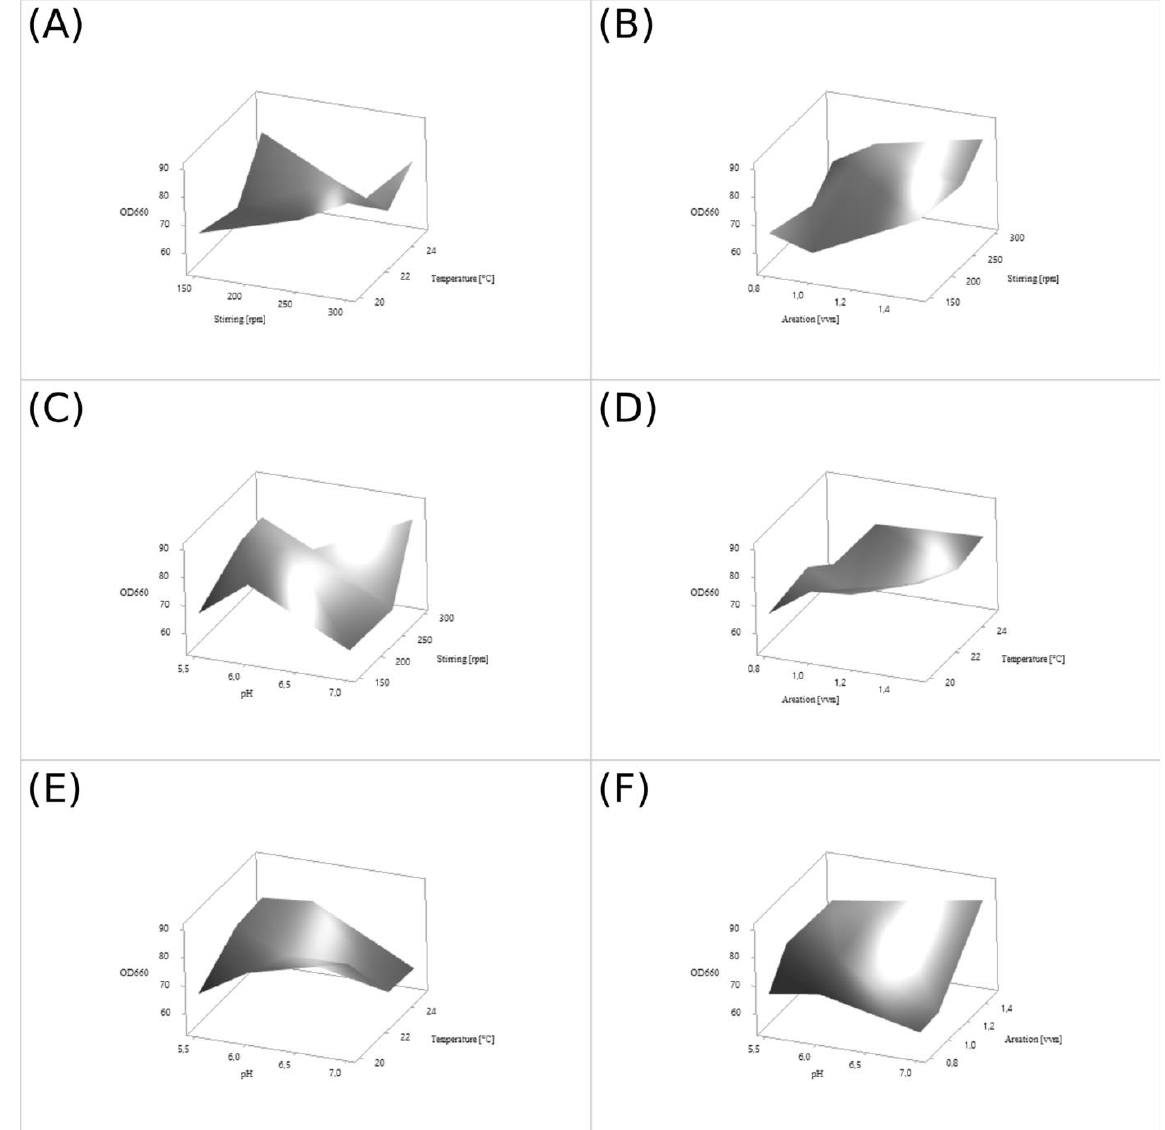
Figure 3. The 3D response plots and corresponding contour plots of yeast biomass production. The correlation between the physical parameters of culture: stirring and temperature ( A ); aeration and stirring ( B ); pH and stirring ( C ); aeration and temperature ( D ); pH and temperature ( E ); pH and aeration ( F ); and the biomass growth (OD 660 ). The maximum values are highlighted. The genome of D. macquariensis strain D50 was sequenced using MiSeq System (Illu- mina, San Diego, CA, USA) at Genomed S.A. (Warsaw, Poland). The resulting assembly of yeast genome sequence has a length of 11,368,350 bp in 128 scaffolds with an N 50 scaf- fold length of 746,630 bp. The draft genome has 34.79% G + C content. The draft genome encodes 202 putative tRNAs (without isotypes) and 4 pseudogenes. Moreover, gene pre- diction and annotation resulted in 5758 CDS encoding putative proteins, including 5204 proteins with predicted function. The maximum and minimum lengths of predicted pro- teins sequences are 4991 and 27 amino acids, respectively. For comparison, the G + C con- tent of salt-tolerant Debaryomyces hansenii var. hansenii strain MTCC 234 isolated from New Zealand soil is 35.42%. The bioinformatics analysis of the draft genome sequence of D. hansenii var. hansenii strain MTCC 234 revealed 5313 predicted proteins, including 5069